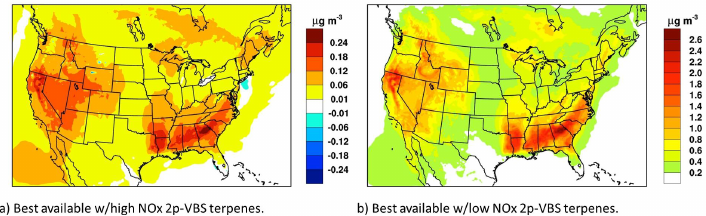
Fig. 8. Difference in total SOA averaged over 15–31 July 2006 between the best available parameter simulation and the base case CMAQ simulation: using the high NO x 2p-VBS parameters for lumped monoterpenes (a) , and using the low NO x 2p-VBS parameters for lumped monoterpenes (b) .